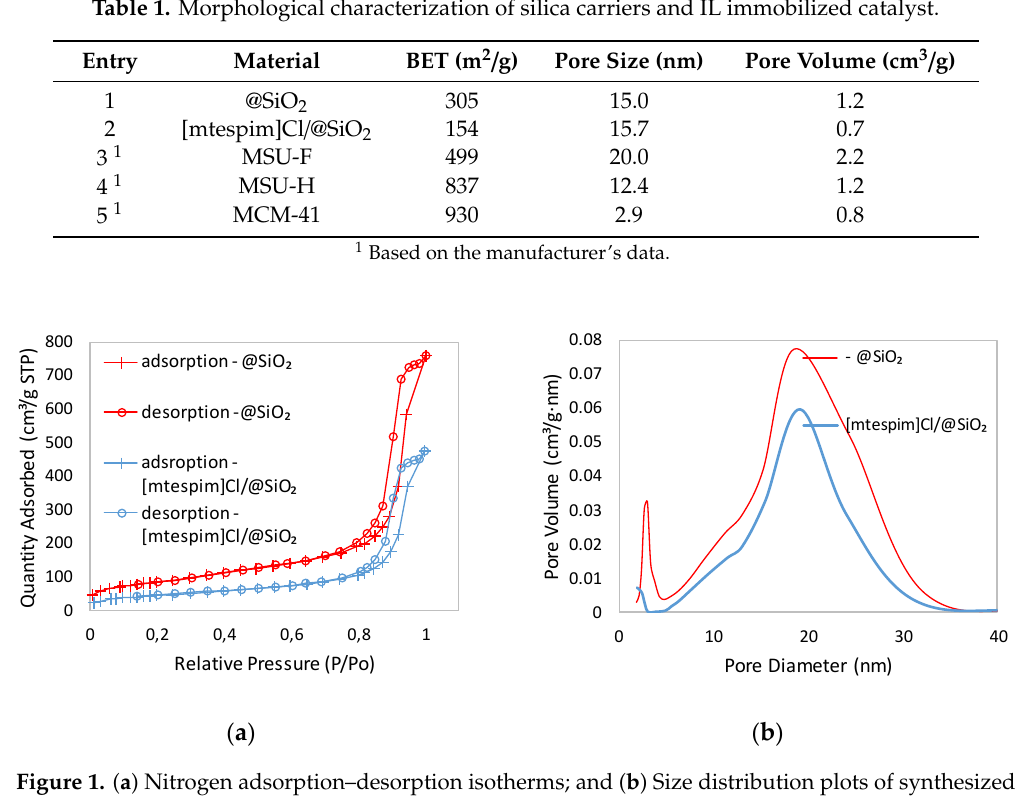
Table 1. Morphological characterization of silica carriers and IL immobilized catalyst.